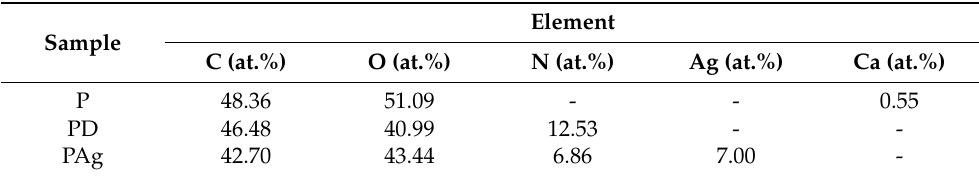
Table 1. EDS analysis of the composition of the surface layer of blank paper (P), paper with a polydopamine coating (PD) and paper after surface